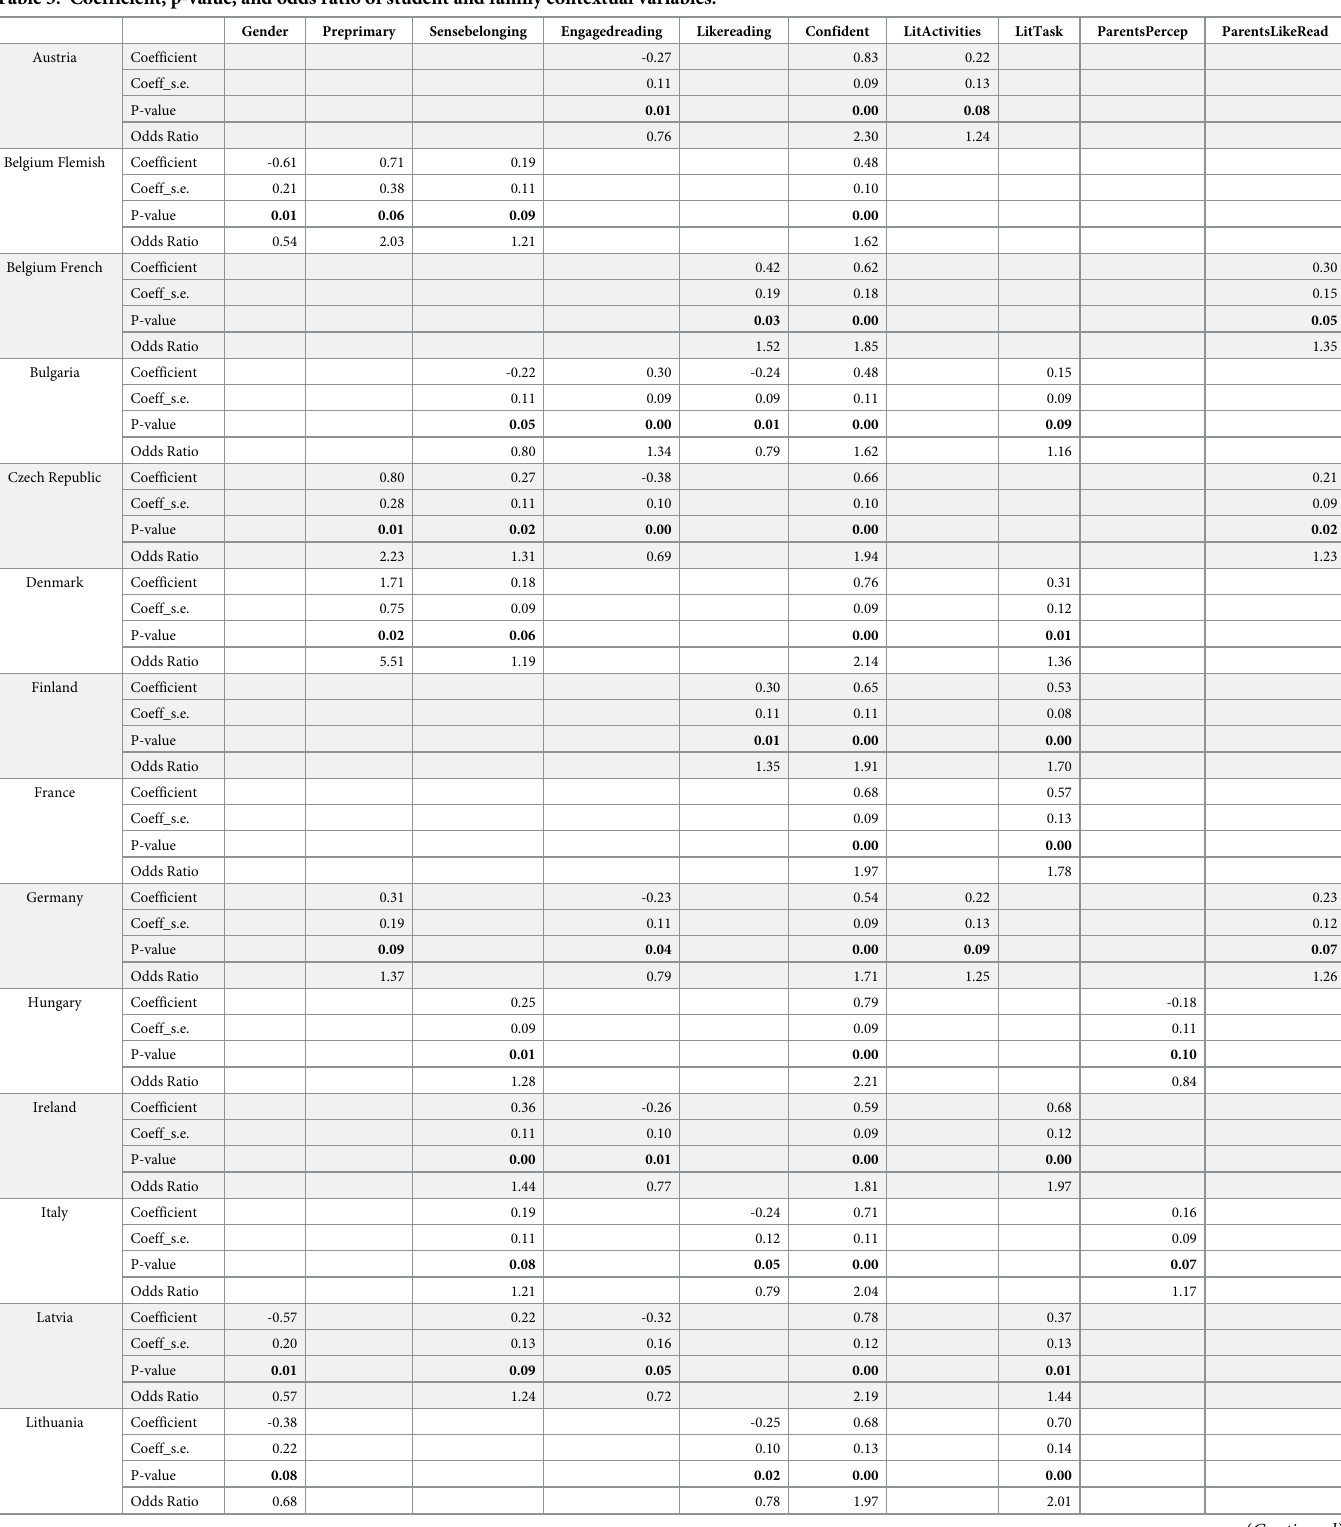
Table 5. Coefficient, p-value, and odds ratio of student and family contextual variables. Gender Preprimary Sensebelonging Engagedreading Likereading Confident LitActivities LitTask ParentsPercep ParentsLikeRead